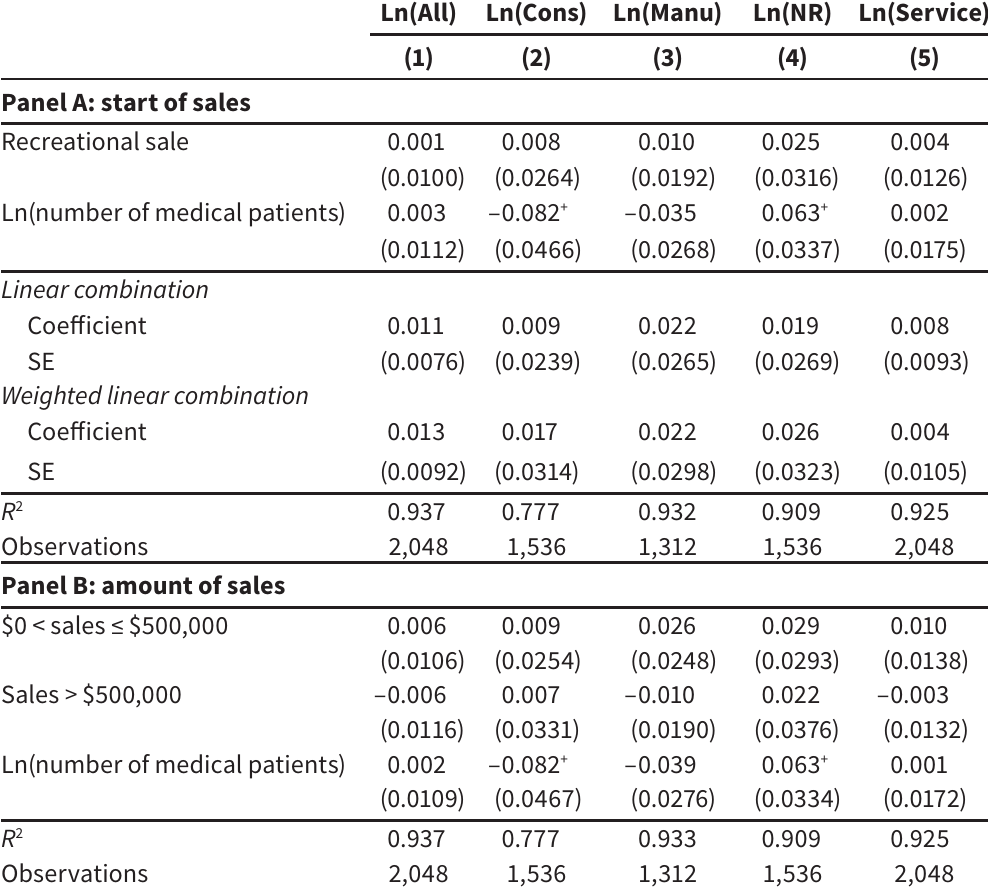
The effect of recreational dispensary entry and sales on wages – regression